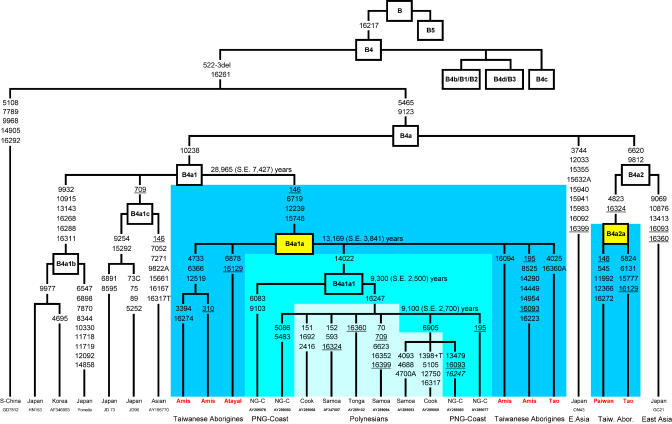
Phylogenetic Tree Relating Haplogroup B4a1 Complete SequencesBase pair exchange is specified only for transversions. Recurrent mutations are underlined. Coalescence times are shown beside nodes.